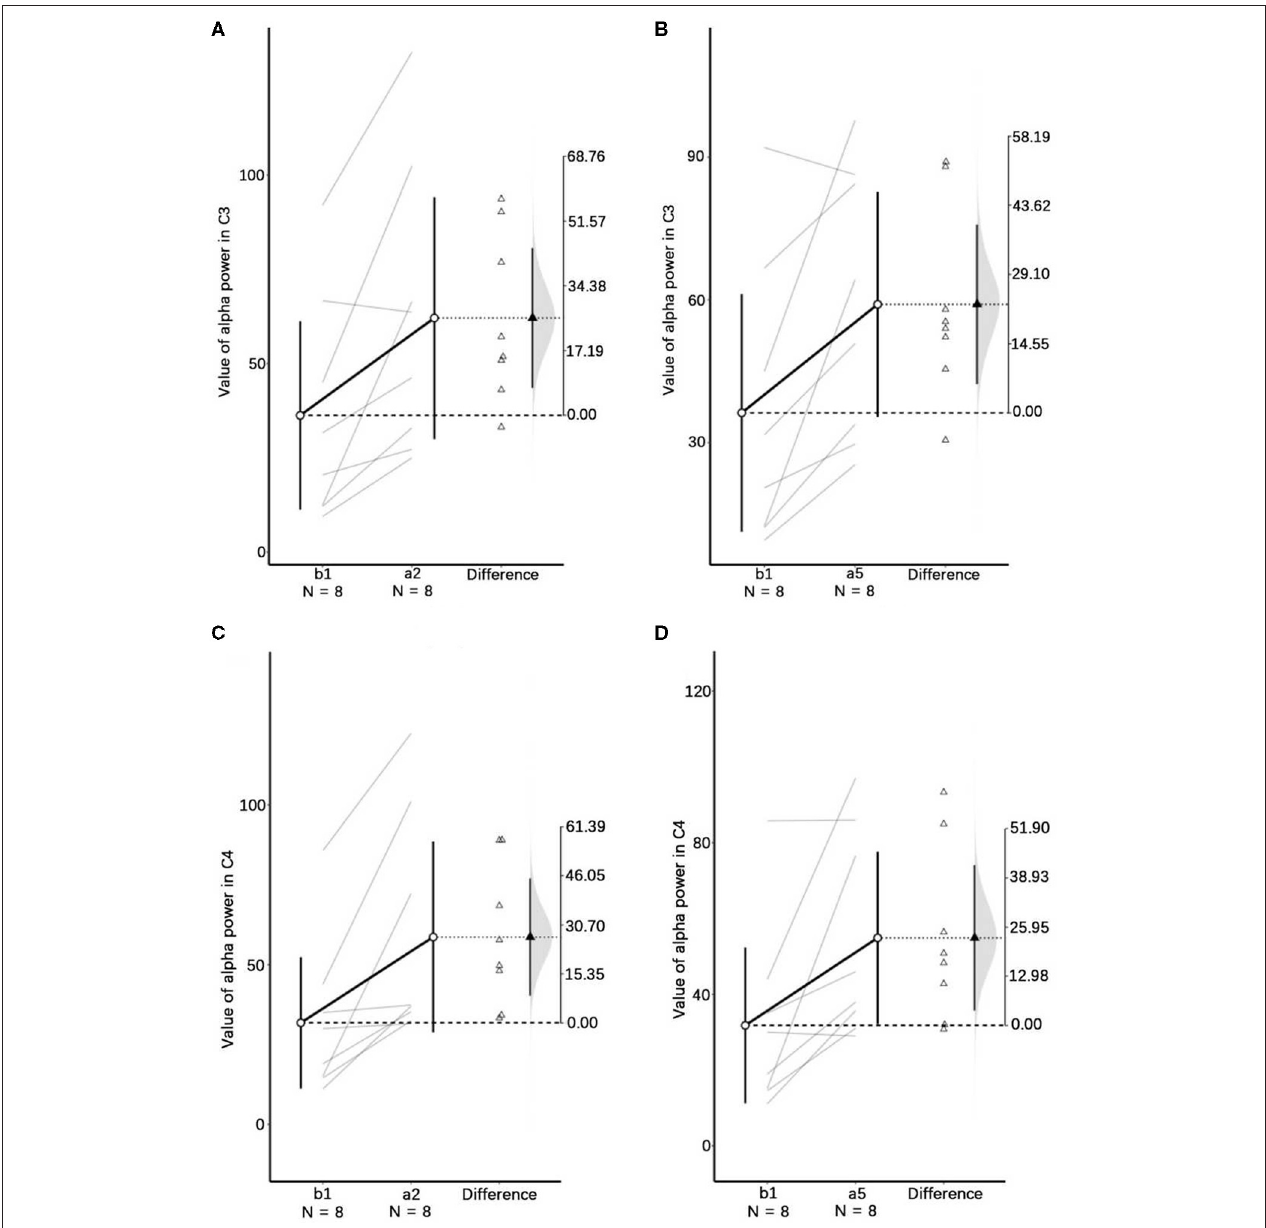
FIGURE 6 | Visualizations emphasizing testing vs. estimation. In this plot, the lines represent the paired participants. The two ends of the line represent the pre- and post-stimulus values of the participant. The circles with error bars represent each group mean with their 95% CI. The triangles show the difference between groups in this paired samples. The shaded curve shows the entire distribution of expected sampling error for the difference between the means. Panels (A–D) , respectively, represent the descriptive plots of b1 and a2, and b1 and a5 on the C3 channel, b1 and a2, and b1 and a5 on the C4